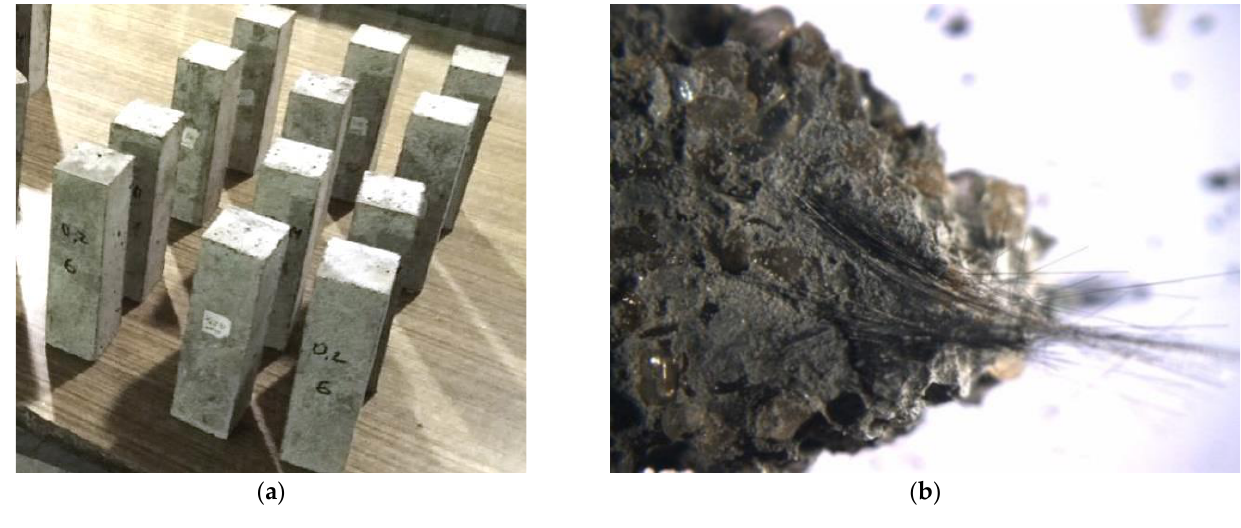
Figure 5. Samples of standard fine-grained concrete beams reinforced with carbon fiber: ( a ) general view of a beam; ( b ) fracture after tests. Table 4. Test results of the samples reinforced with carbon fiber.